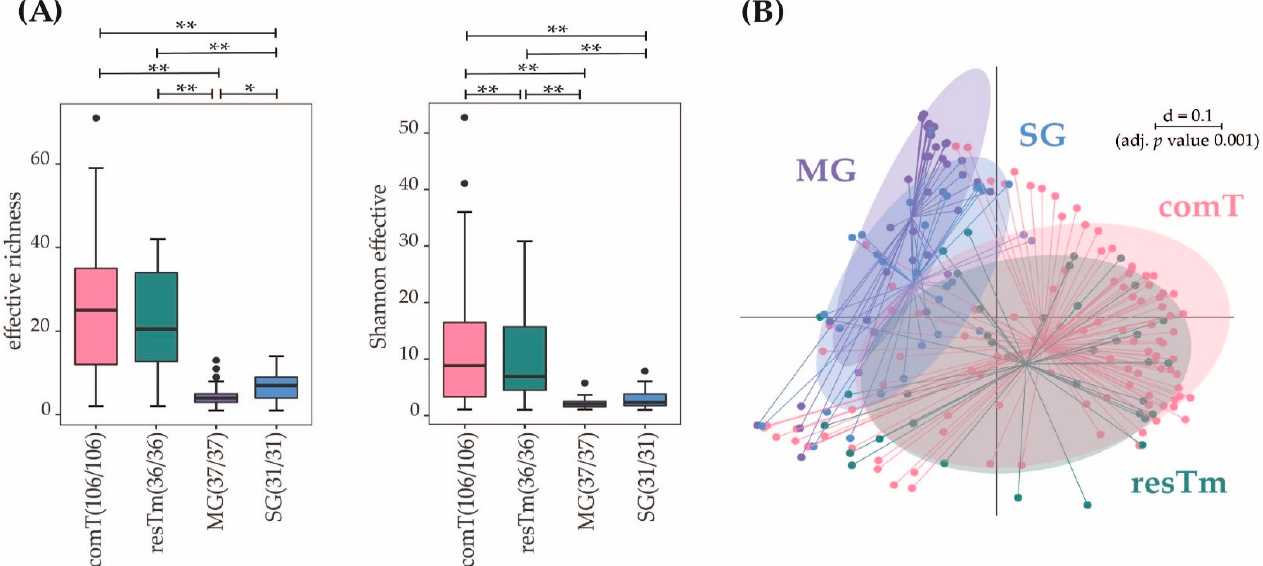
Figure 1. ( A ) α -diversity shown as effective richness and Shannon effective diversity between different tick tissue samples. Box-plots indicating median (thick bar), upper and lower quartile (within box), and standard deviation (whiskers). Outliers are depicted as dots. Brackets above the individual box-plots point to significance levels for pairwise comparison. ( B ) β -diversity of all sample types are displayed in a multidimensional-scaling (MDS) plot. The scale is an indicator for the differences in the phylogenetic makeup of microbiota between samples ( β -diversity) based on general UniFrac distances (d = 0.1, 10% difference). comT, complete Ixodes ricinus tick; resTm, residual tick material; MG, midgut; SG, salivary gland. p value summary: * p ≤ 0.05, ** p ≤ 0.01. At the phylum level, Pseudomonadota (previously Proteobacteria) were dominant in all types of samples. Strikingly, Actinomycetota (previously Actinobacteria) was the only